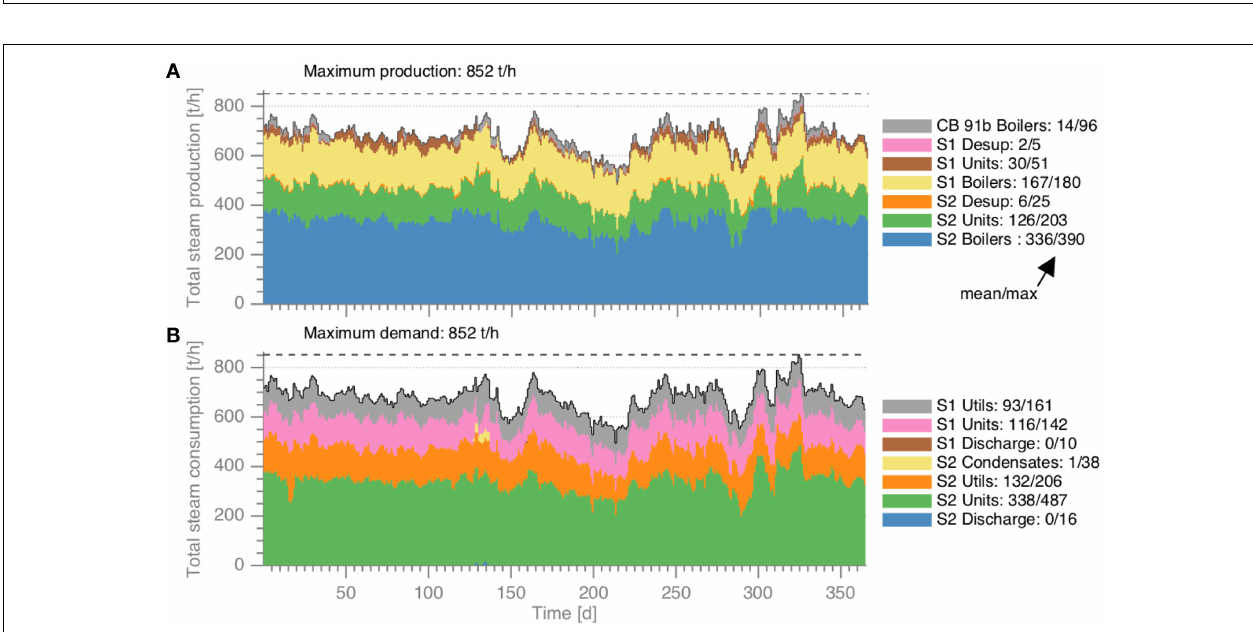
FIGURE 7 | Steam distribution under nominal operating conditions for Site 1 (A) and Site 2 (B) .